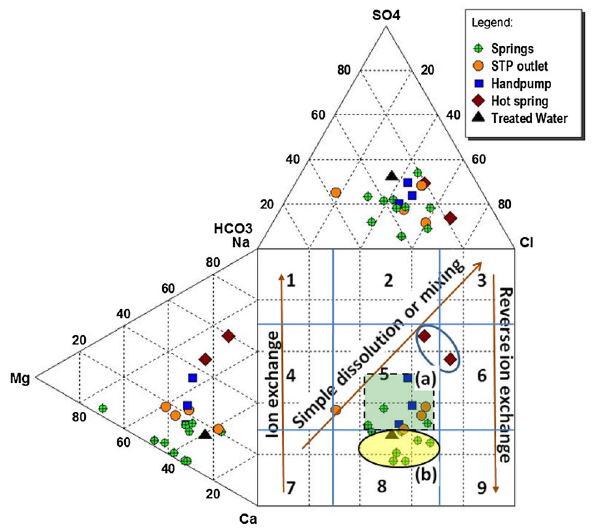
Fig. 7 Durov plot depicting hydrochemical processes involved in water samples